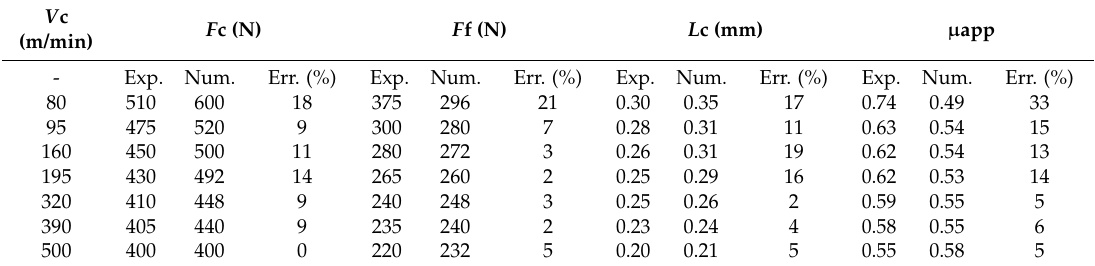
Table 6. Comparison between experimental data and ALE-FE results.